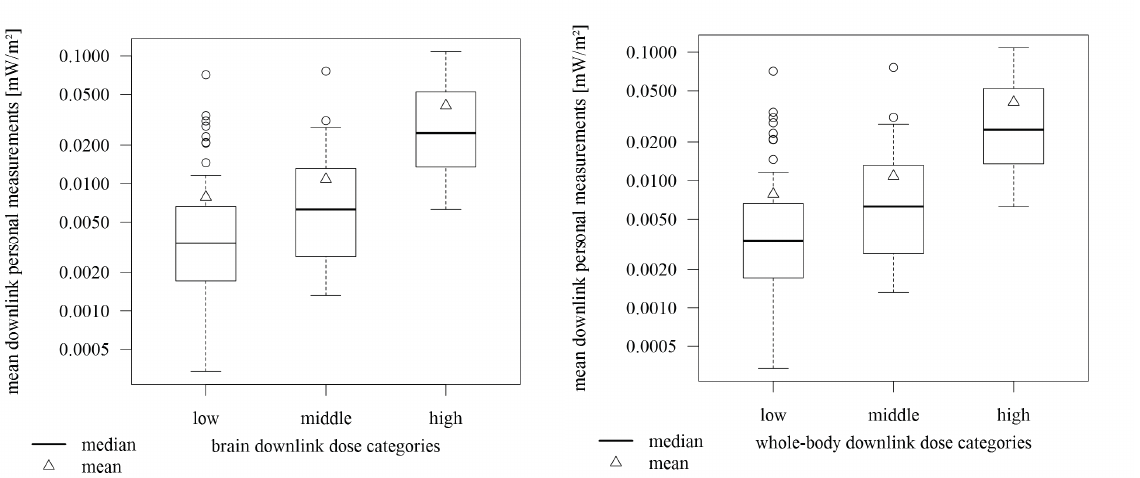
Figure 4. Comparison of predicted dose measures and personal measurements using the three dose categories <50th percentile (low), 50th–90th percentile (medium) and >90th percentile (high); First row: total dose vs. total personal measurements; Second row: far-field dose vs. total personal measurements; Third row: downlink dose vs. downlink personal